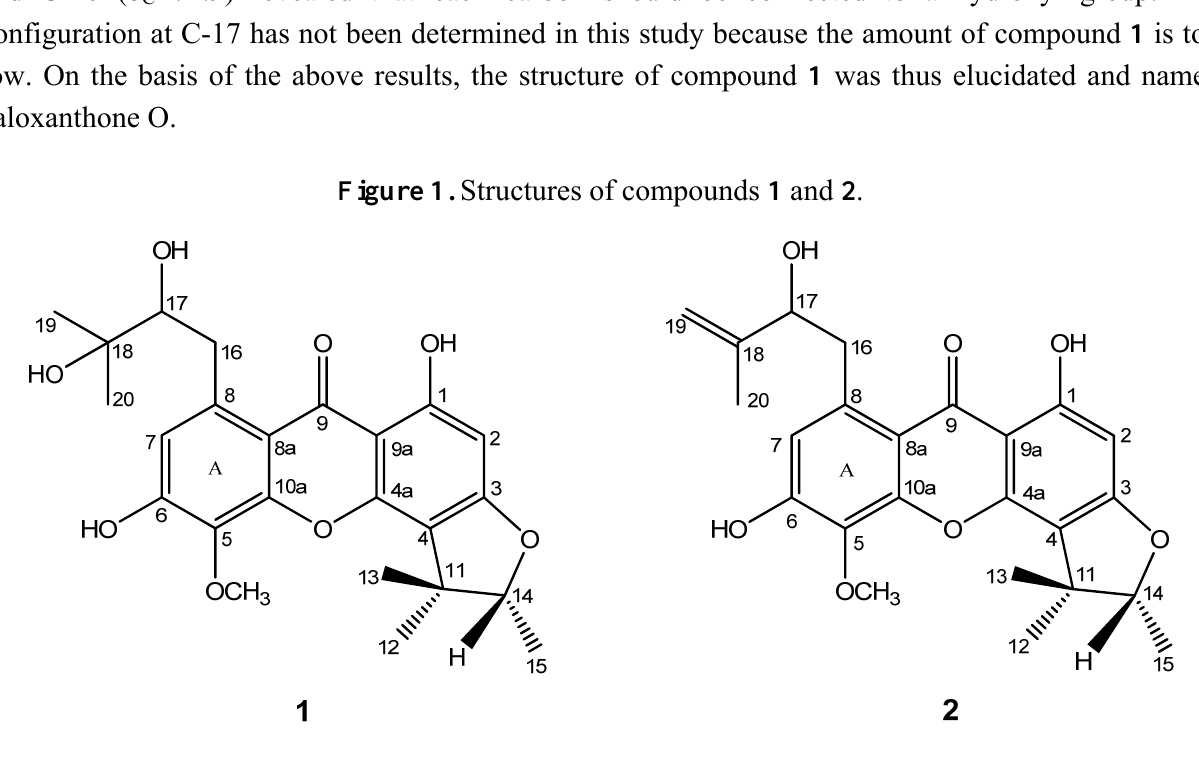
Figure 2. Key HMBC and ROESY correlations of compounds 1 and 2